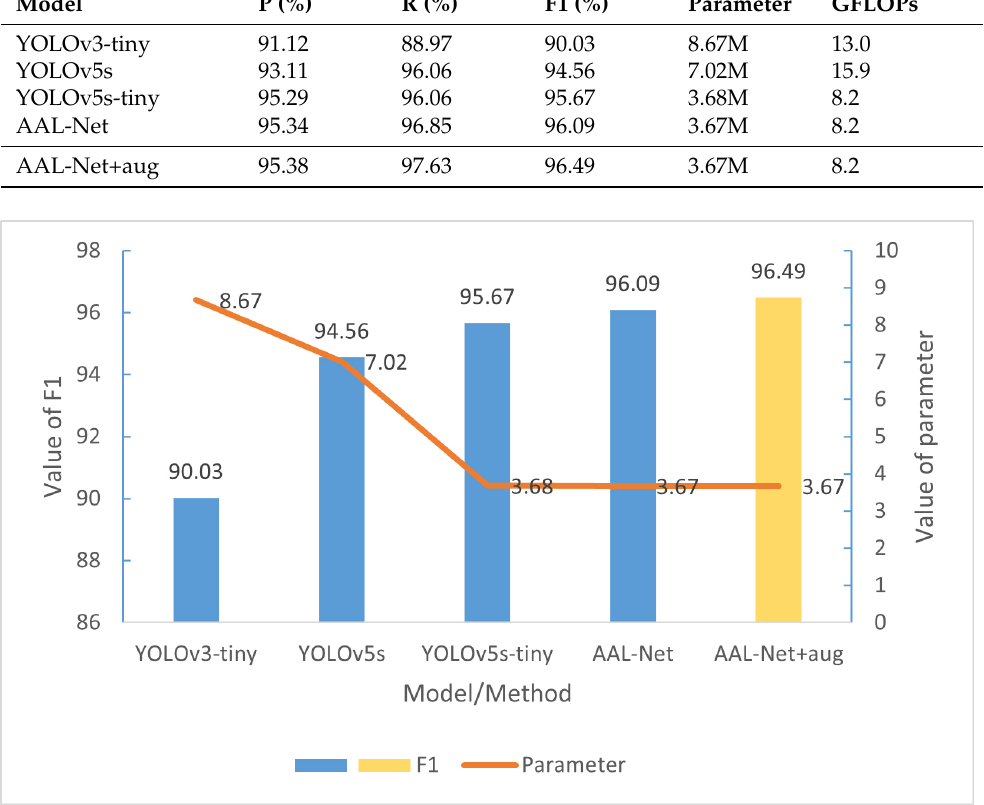
Figure 12. In the pothole600 dataset, the comparison between F1 values and parameter values of different methods, the horizontal axis represents different methods, the left half of the vertical axis represents F1 values, and the right half of the vertical axis represents parameter values.